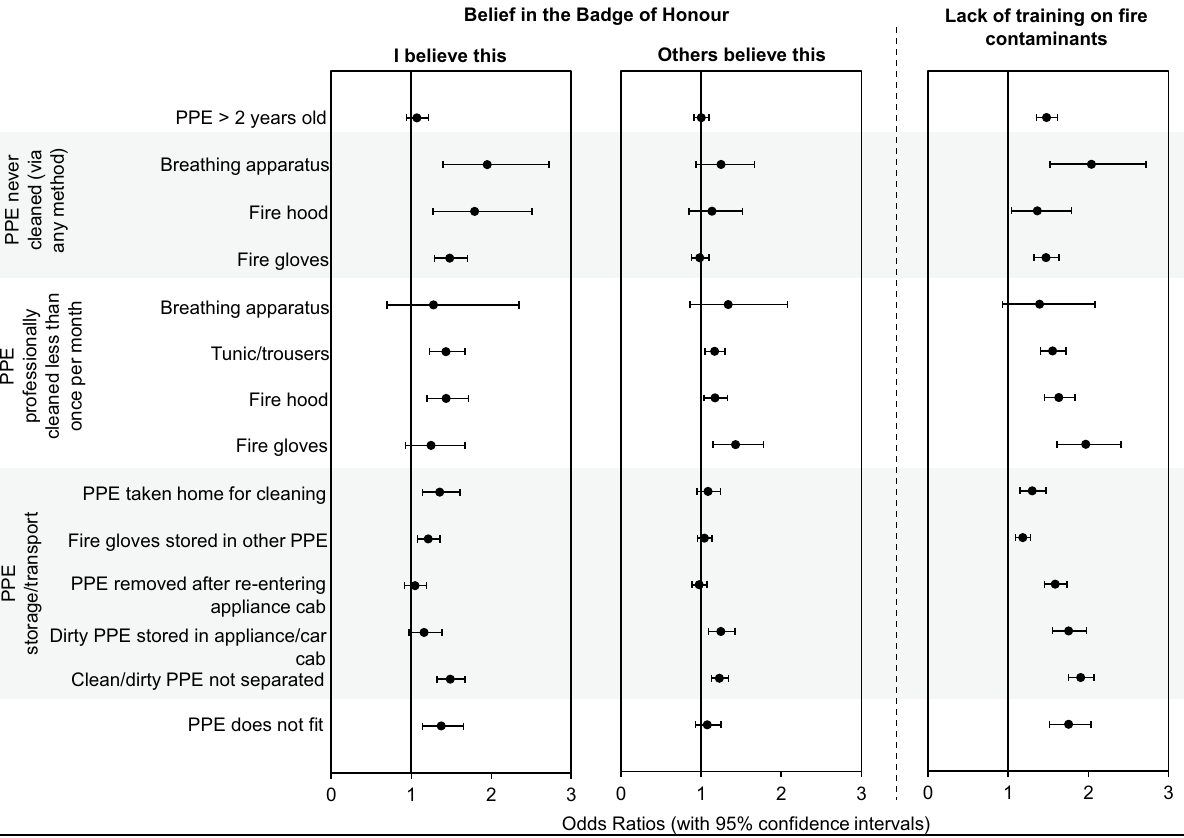
Figure 5. Belief in the BoH/lack of training and crude odds ratios for engaging in negative PPE storage or cleaning practices . Although the survey asked firefighters whether they sent breathing apparatus and fire gloves for professional cleaning—it should be noted that sending these items for external, professional cleaning is not (currently) standard practice 10